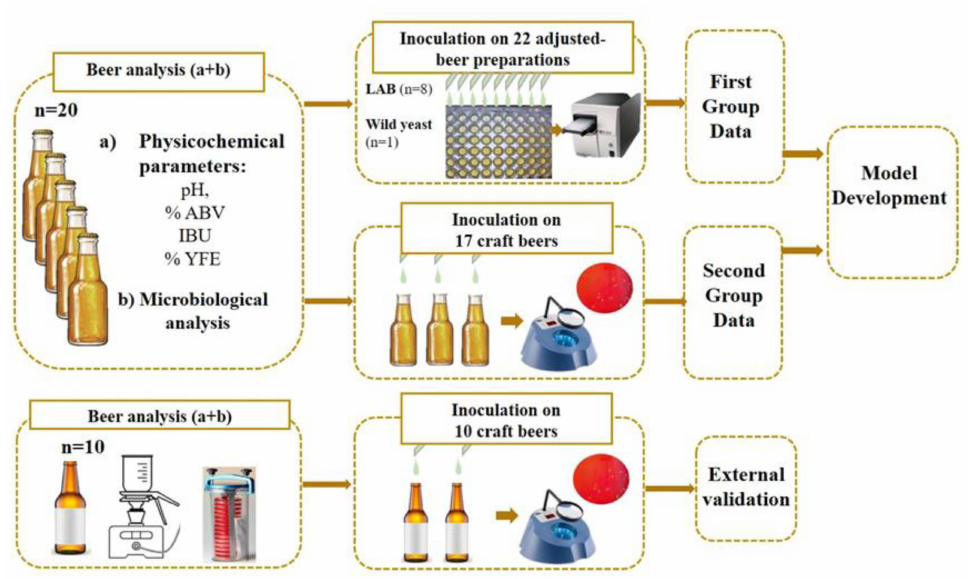
Figure 1. Workflow study scheme.